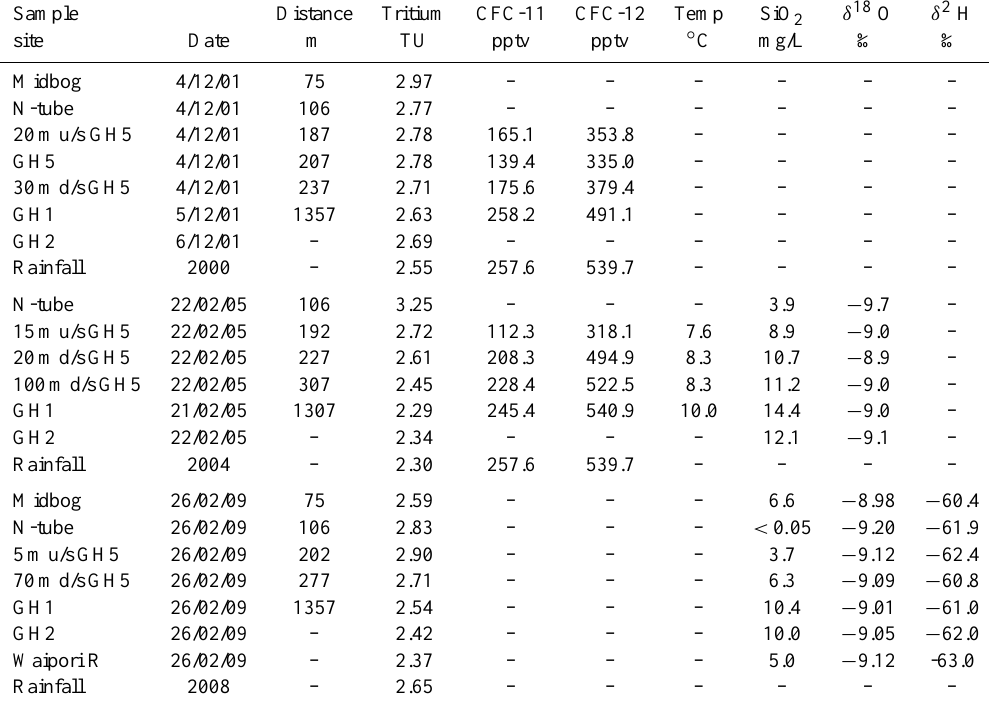
Table 1. Analytical results for samples collected from the Glendhu Catchments. Sample